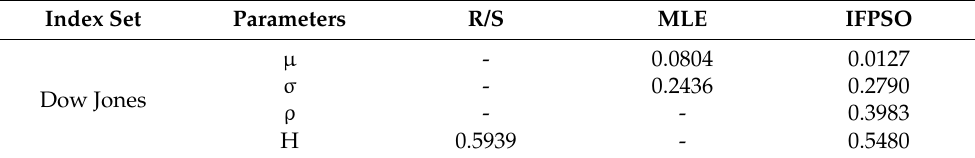
Table 10. MFBM model parameters and optimization results for the Dow Jones index.